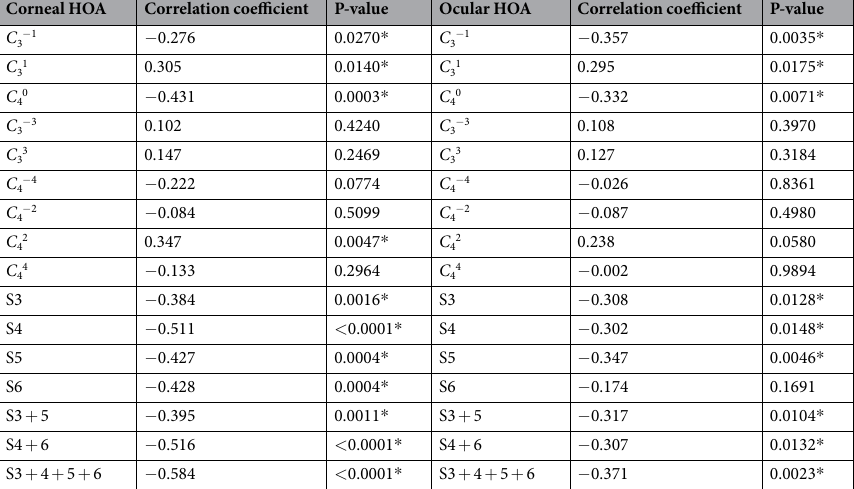
Table 3. Results of univariate analysis between averaged HOA components and axial elongation. HOA = higher-order aberration; C 3 − 1 = vertical coma aberration; C 31 = horizontal coma